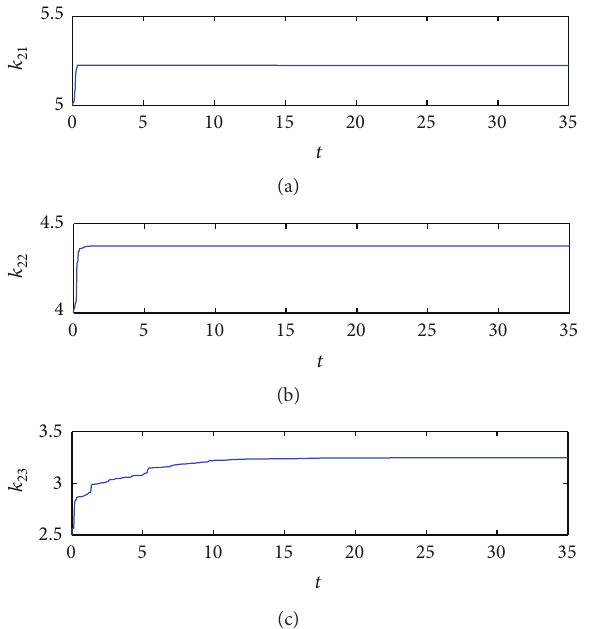
Figure 10: The trajectories of the adaptive laws 𝑘 21 , 𝑘 22 , and 𝑘 23 in Example 1.